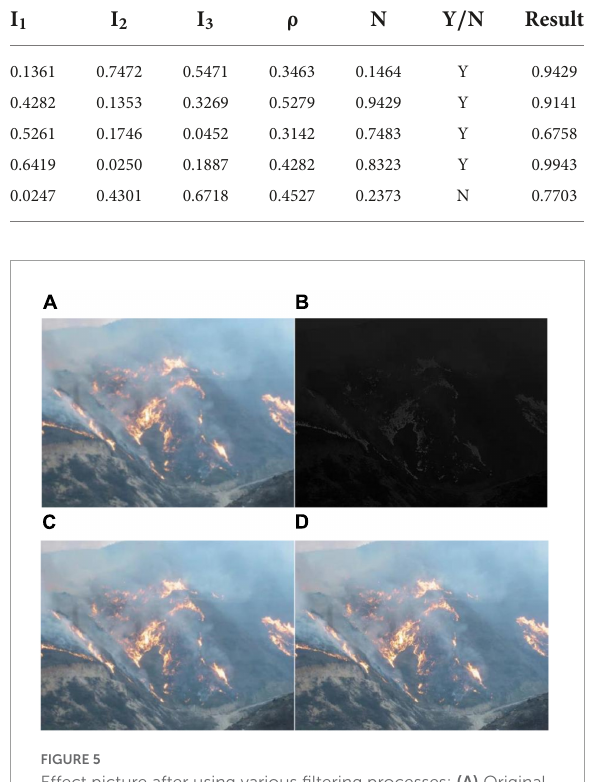
FIGURE5 Effect picture after using various filtering processes: (A) Original drawing, (B) gabor filtering, (C) mean filtering, and (D) gaussian filtering.